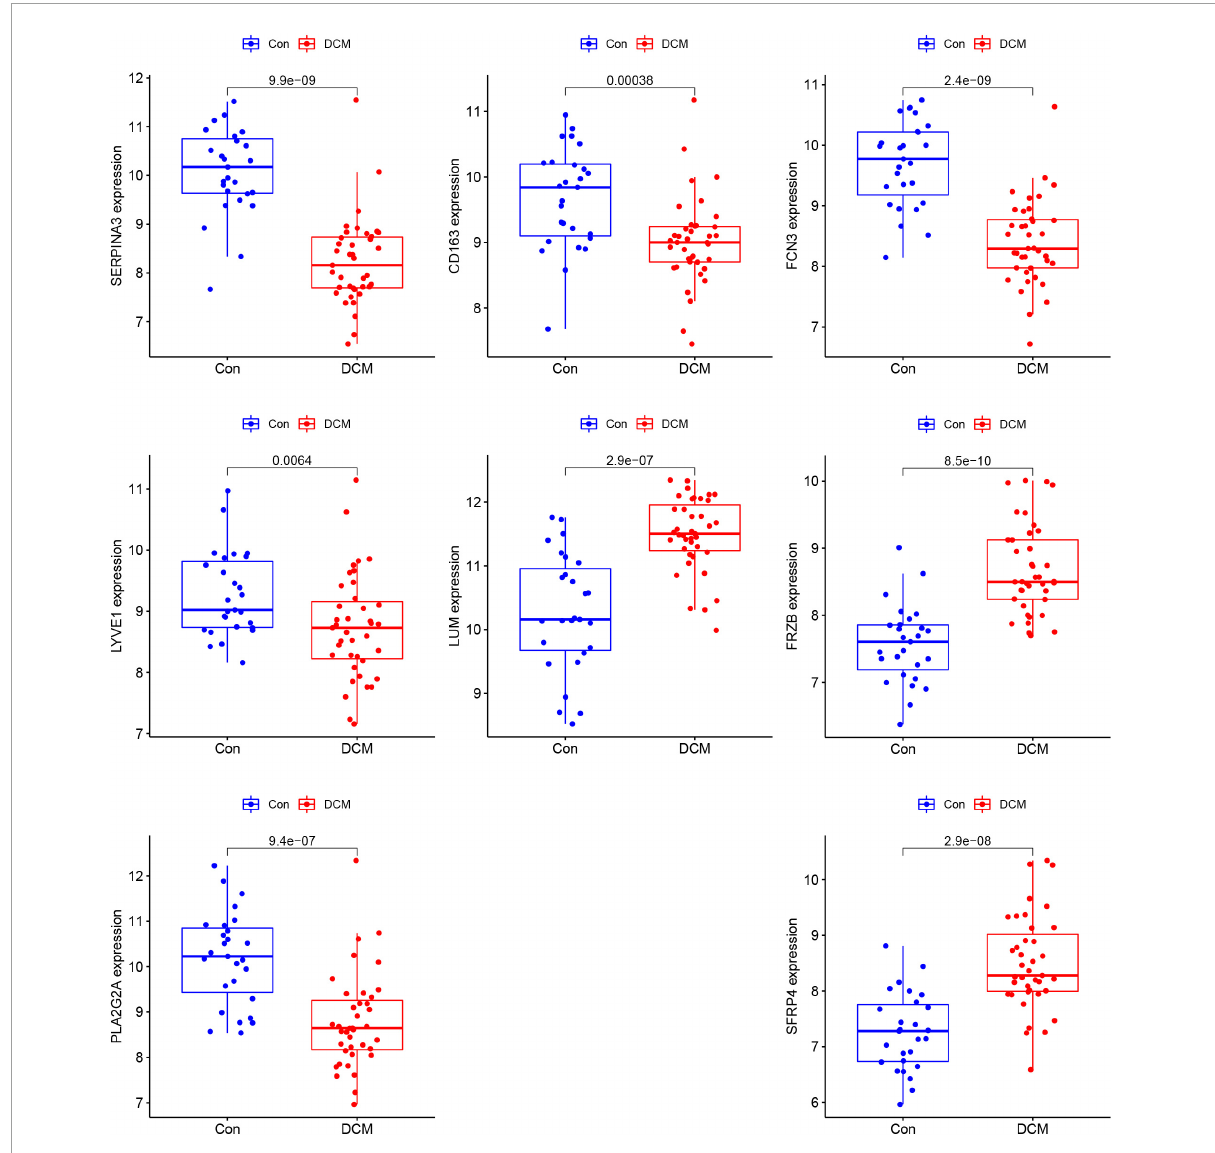
FIGURE5 The comparison of the 8 genes between dilated cardiomyopathy (DCM) and healthy in testing